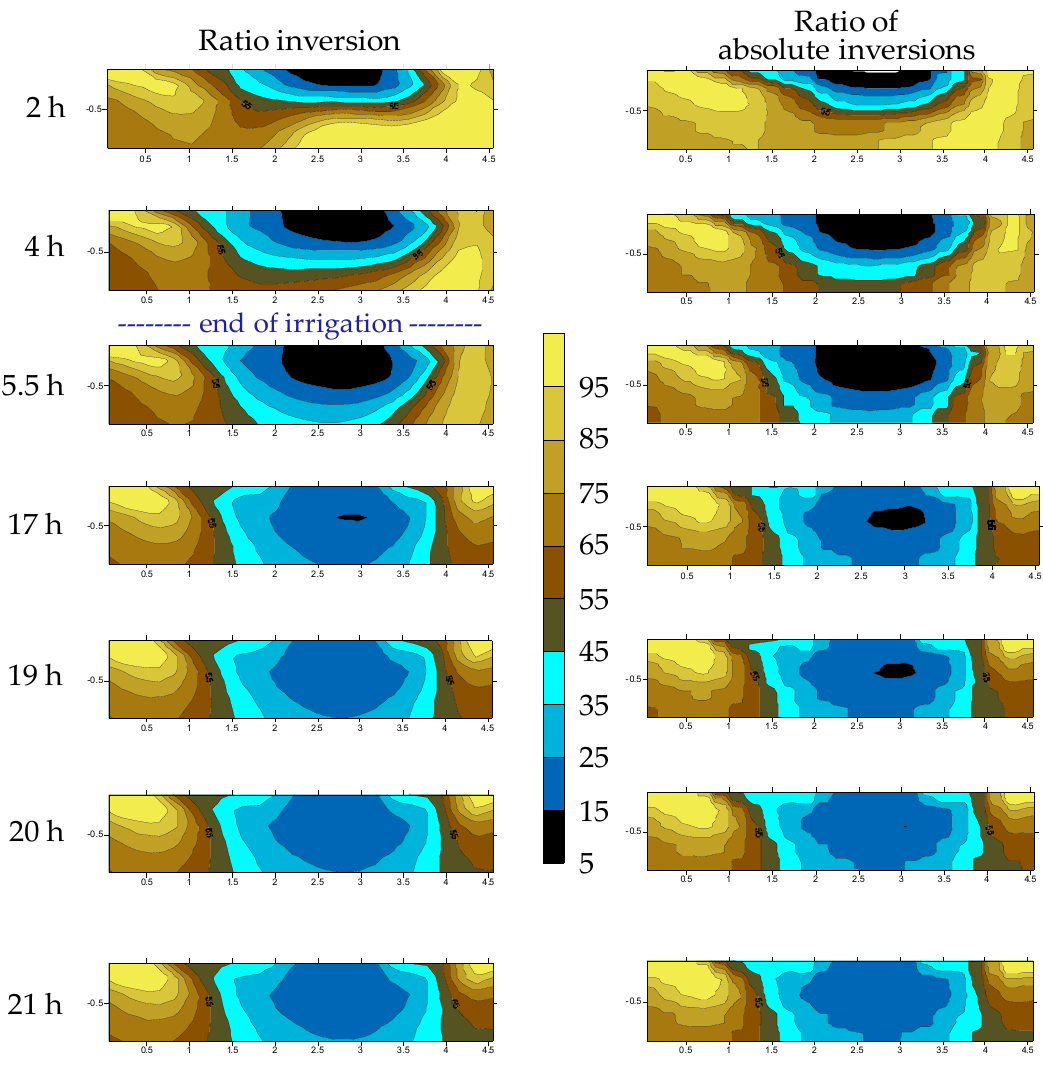
Figure 10. Grugliasco site, August 2009. Relative ERT images along the transverse line (see Figure 3 for location). Both results of ratio inversion and ratios of absolute inversion are shown as percentage of the background (pre-irrigation) values. In this case the two approaches yield very similar results, as the resistivity changes occur homogeneously across the measurement line (no 3D effects).